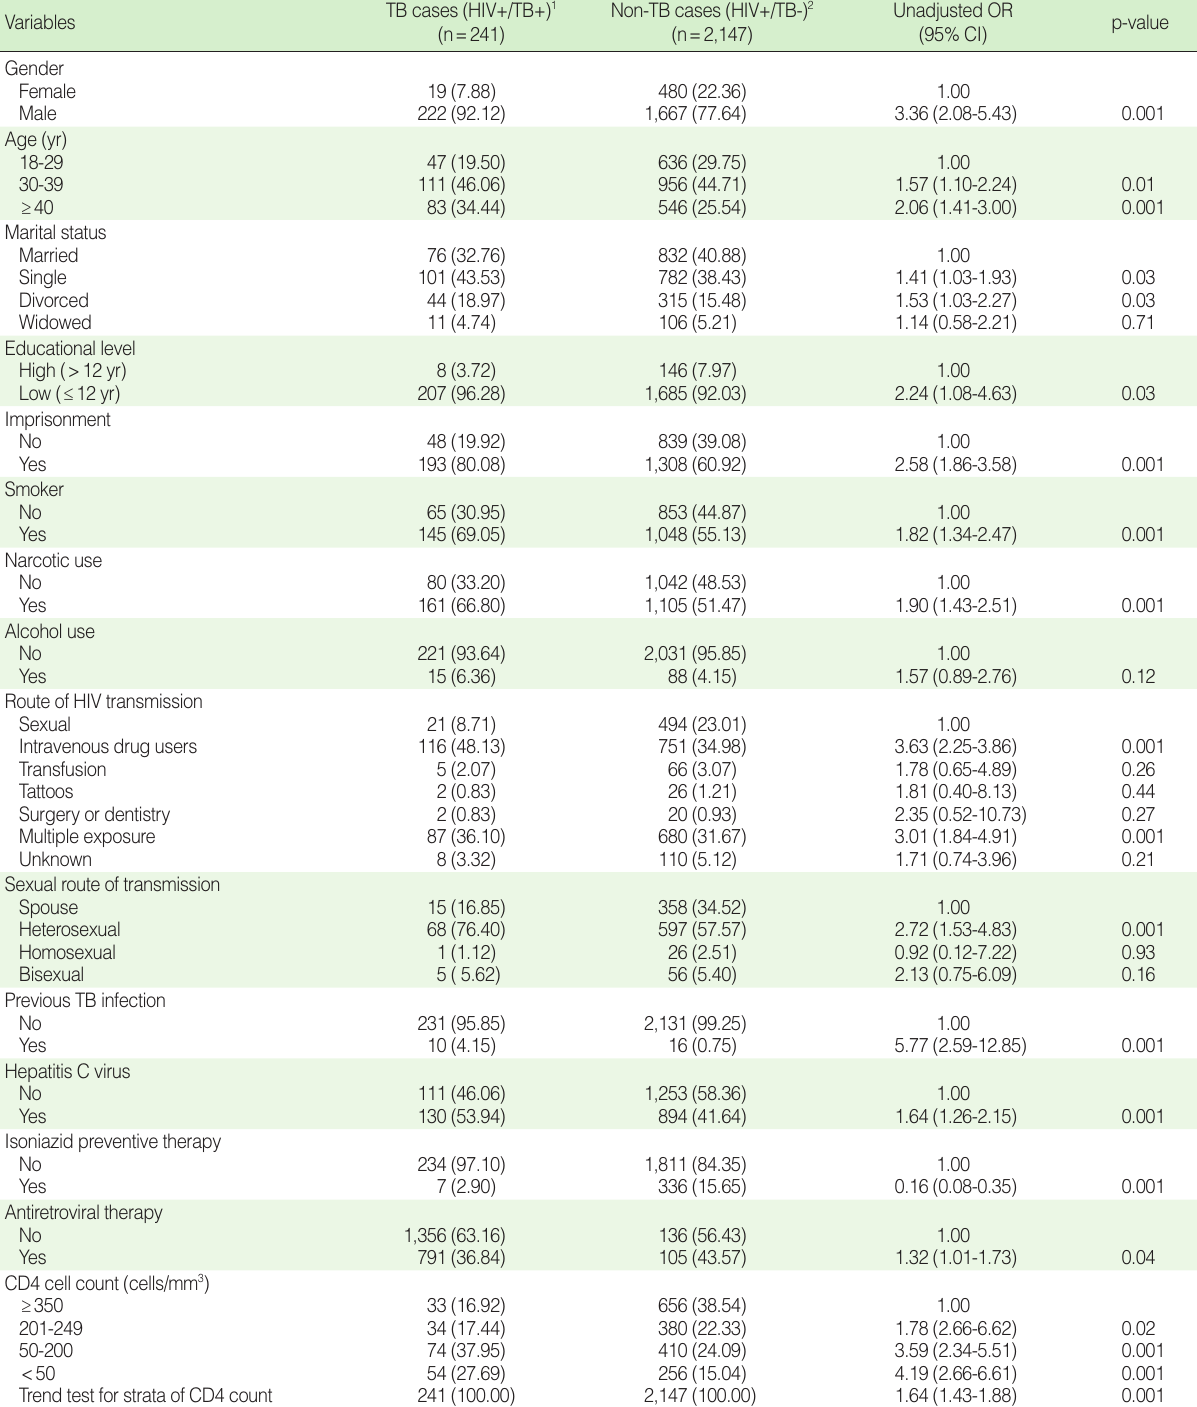
Table 1. Results from the bivariate logistic regression analysis of binary and continuous predictors of M. tuberculosis /HIV co-infection using unadjusted odds ratios